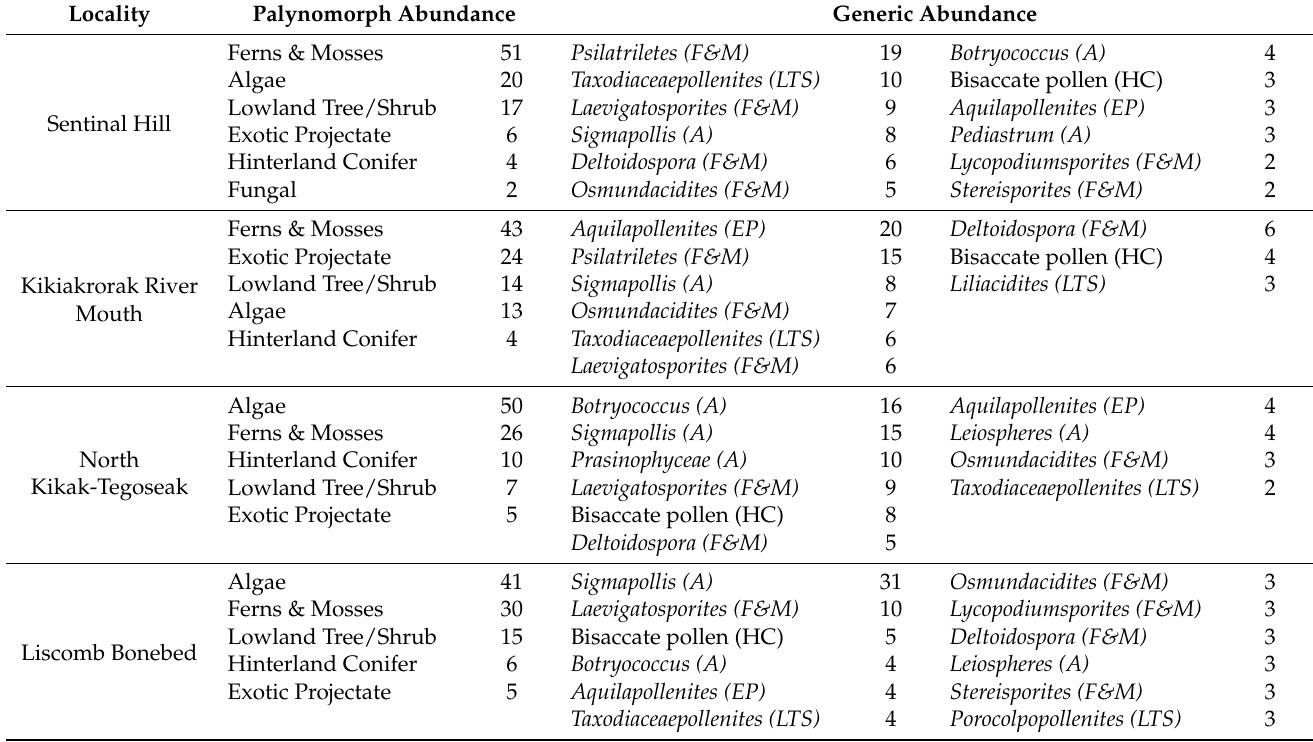
Table 4. Summary of the biotic composition of localities. Abundance of ecological groups shown for groups with 2% or greater abundance. Generic abundances displayed for taxa comprising 75% of total fossil counts of each locality. Locality